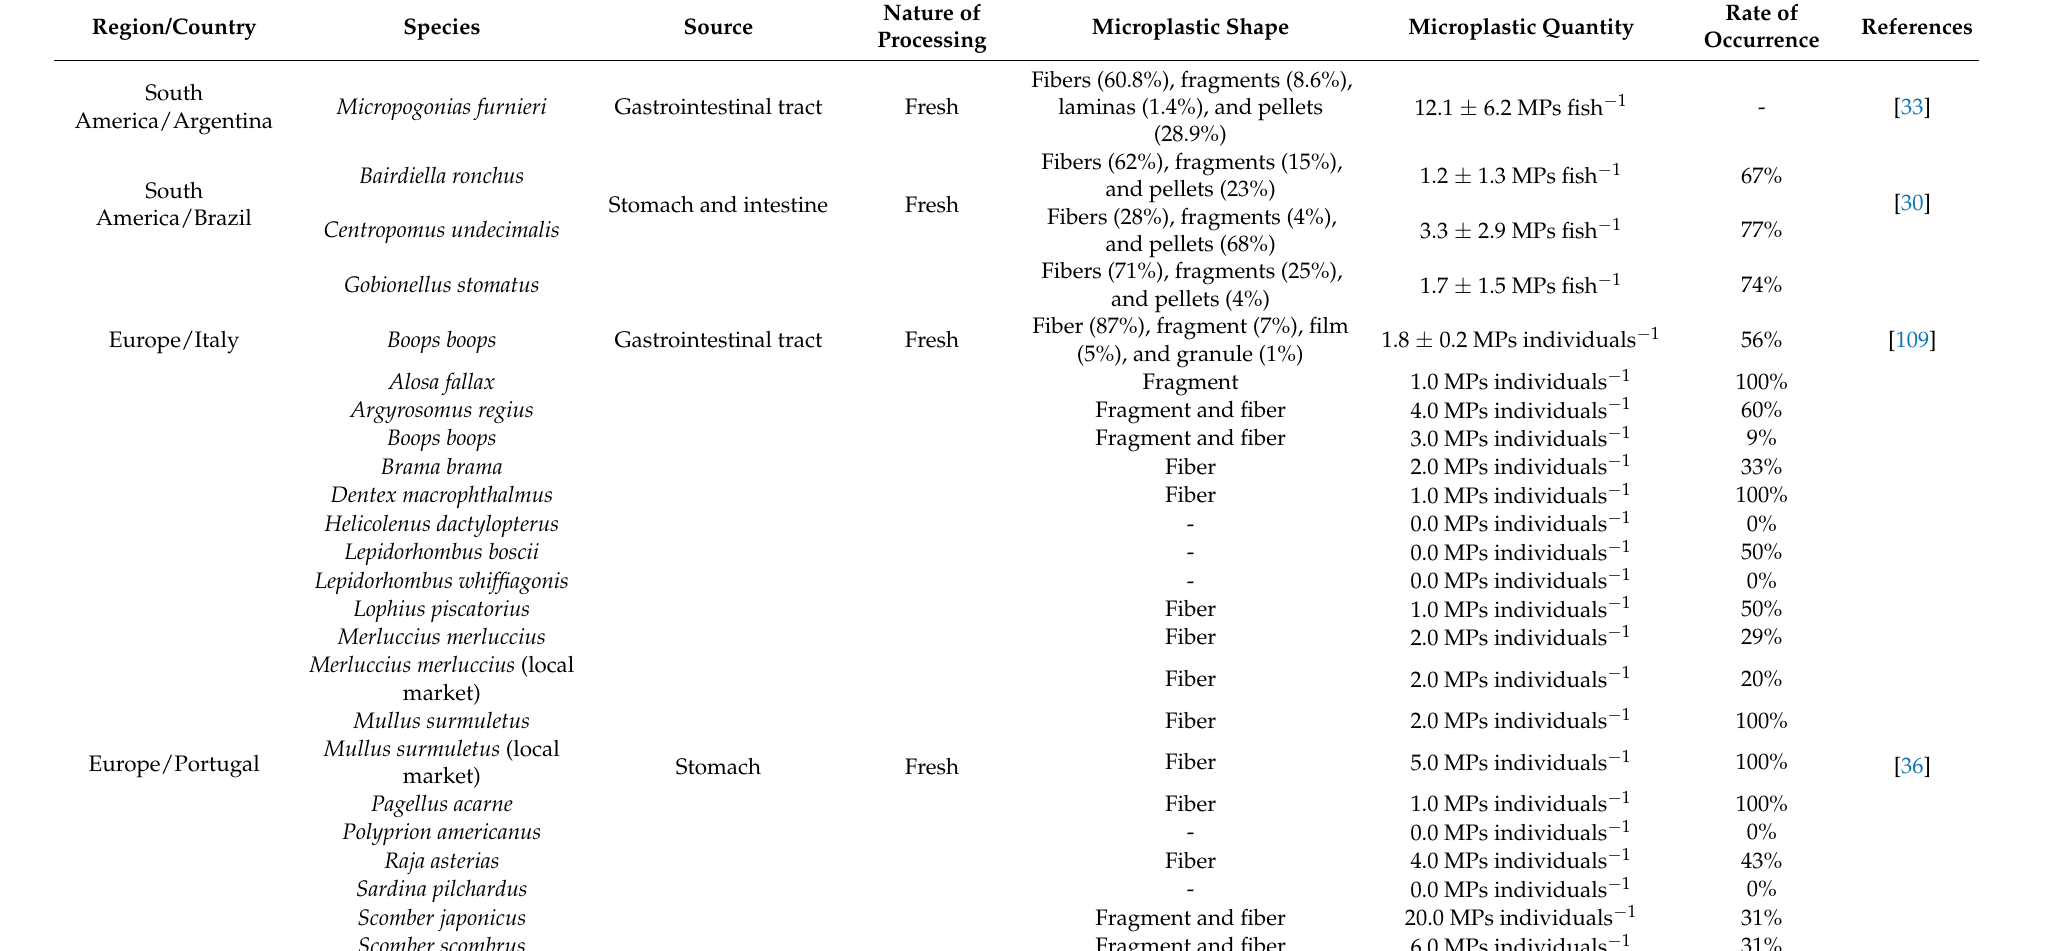
Table 2. Region-wise detection of microplastics in marine